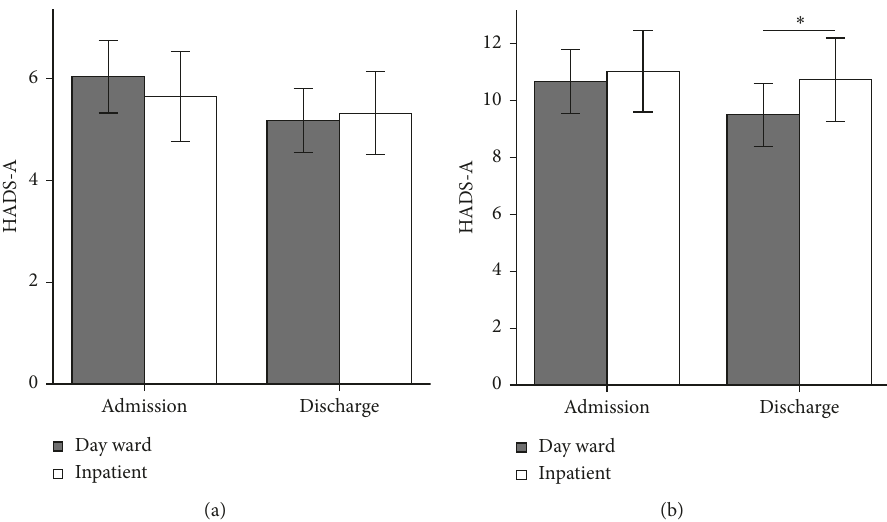
Figure 3: Comparison of anxiety and depression between the 2 groups using the HADS. HADS, Hospital Anxiety and Depression Scale; HADS-A, HADS-anxiety; HADS-D, HADS-depression. ∗ P < 0 . 05. Error bars: 95% confidence intervals.